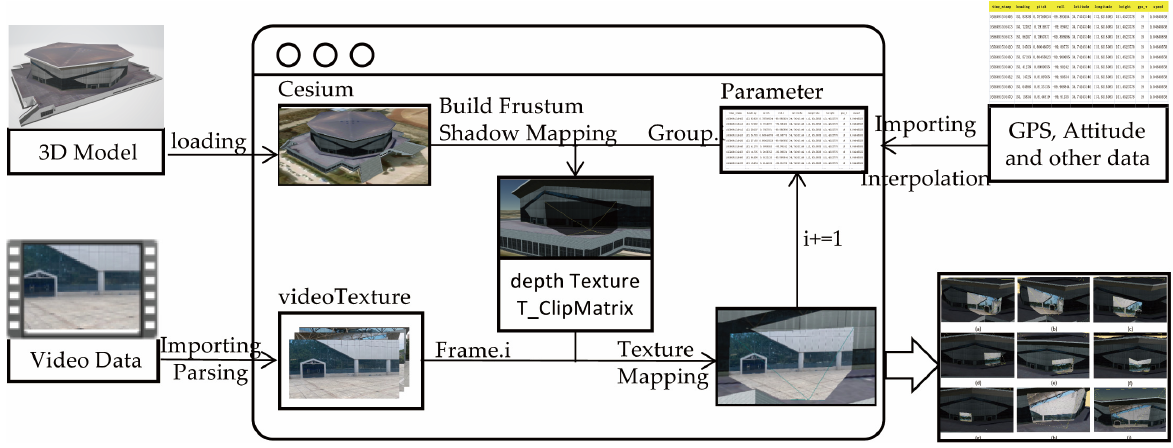
Figure 7. Dynamic fusion of mobile video.